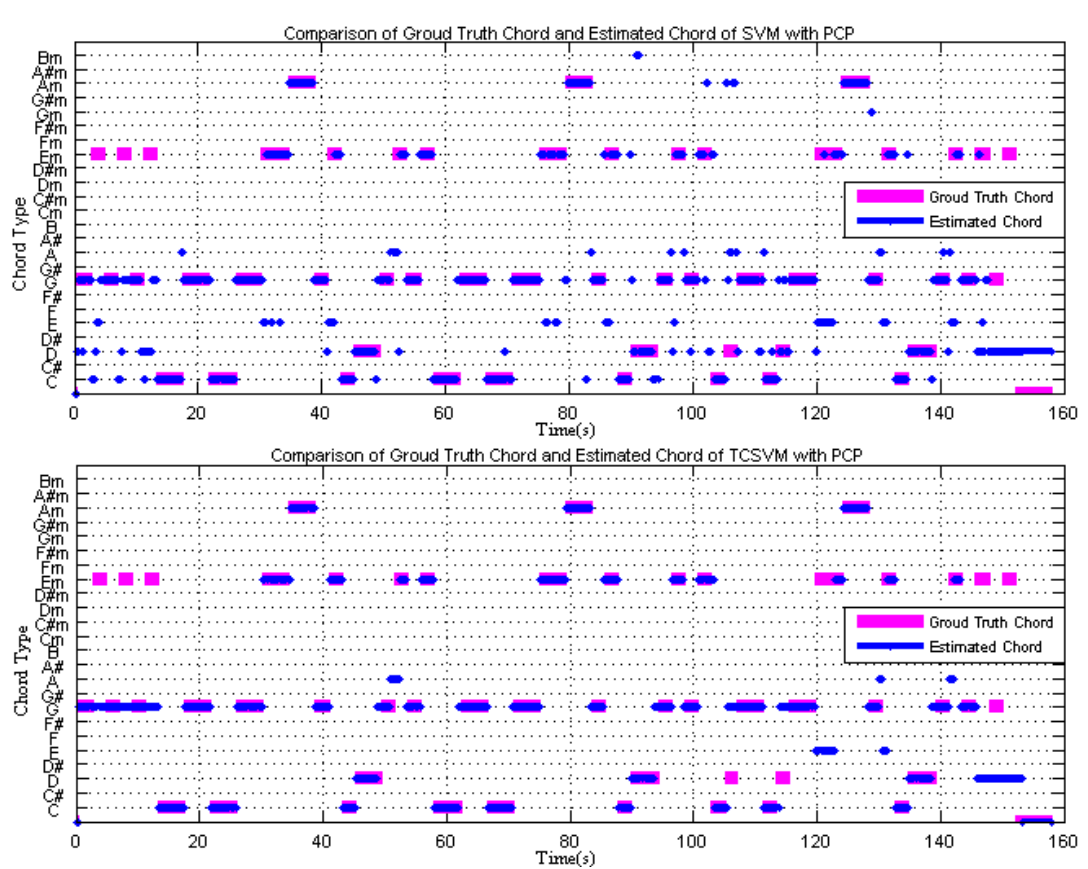
Figure 6. Comparison of ground truth and estimated chords using SVM ( top ) and TCSVM ( bottom ).